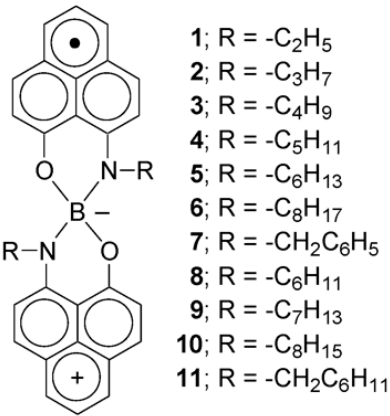
Figure 1. Molecular structure of substituted spirobiphenalenyl boron radicals. Adapted from reference [4]. Reproduced with permission from reference [4], published by MDPI, 2016.